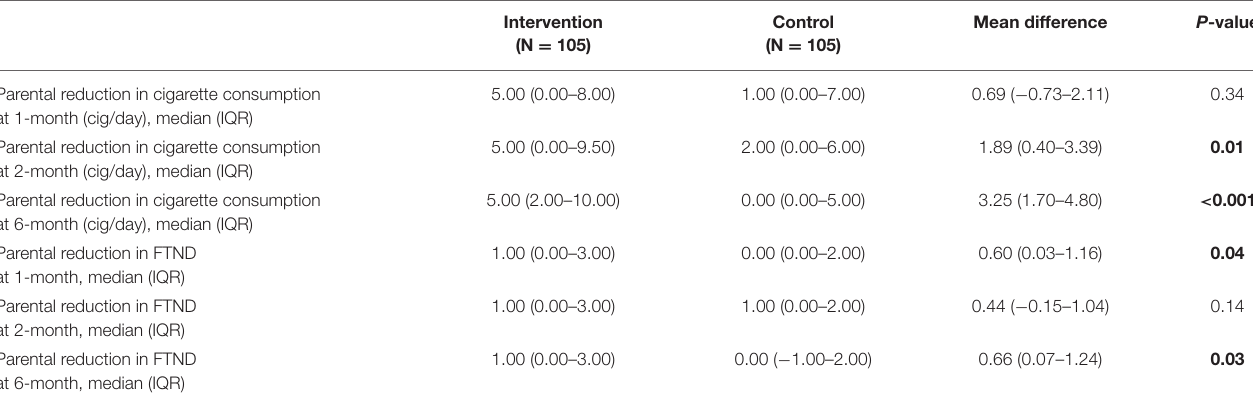
TABLE 5 | Parental self-reported reductions in cigarette consumption and FTND ( N = 210) (sensitivity analyses).